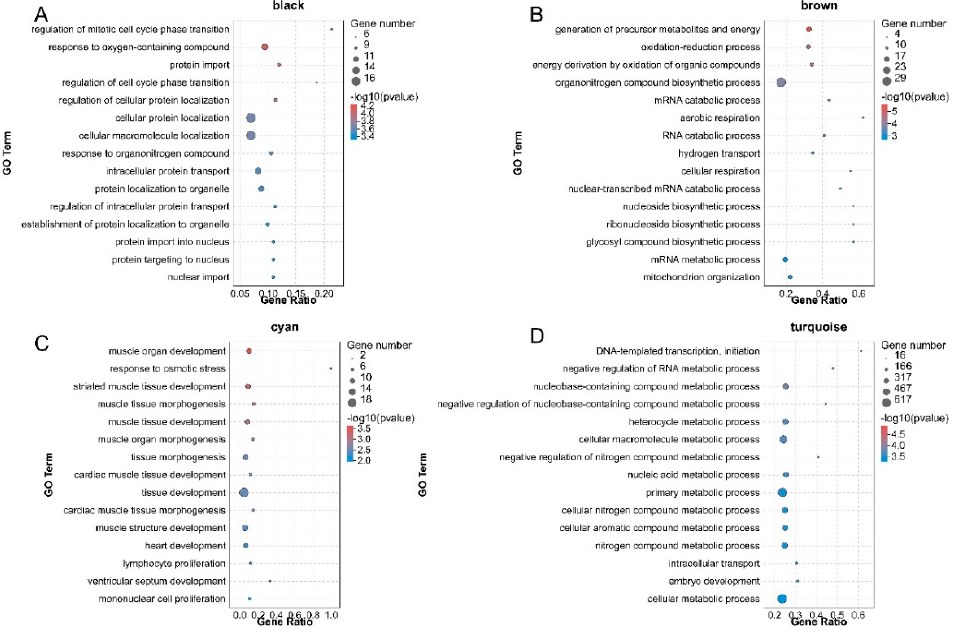
Figure 4. Bubble plots of the GO enrichment analysis of DEGs in the four pigeon skeletal muscle − related modules. ( A – D ) represent GO enrichment analysis of DEGs in black, brown, cyan and turquoise modules. Colours from red to blue indicate p − value from small to large. The bubble size indicates the number of DEGs included in each biological process.